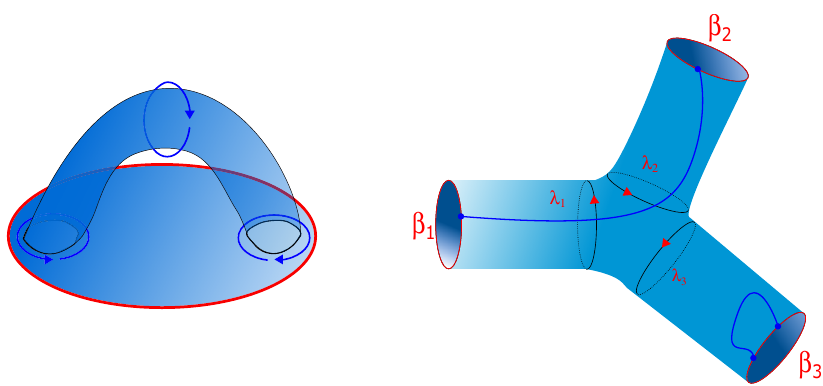
Figure 15 . Left: disk with one handle attached. The blue arrows are indicative of a choice of Cauchy slices to do the BF evolution calculation. Right: multiple Schwarzian boundaries with bilocals in between. Conjugacy class elements gluing the boundary annuli to the three-holed sphere are labeled by λ i